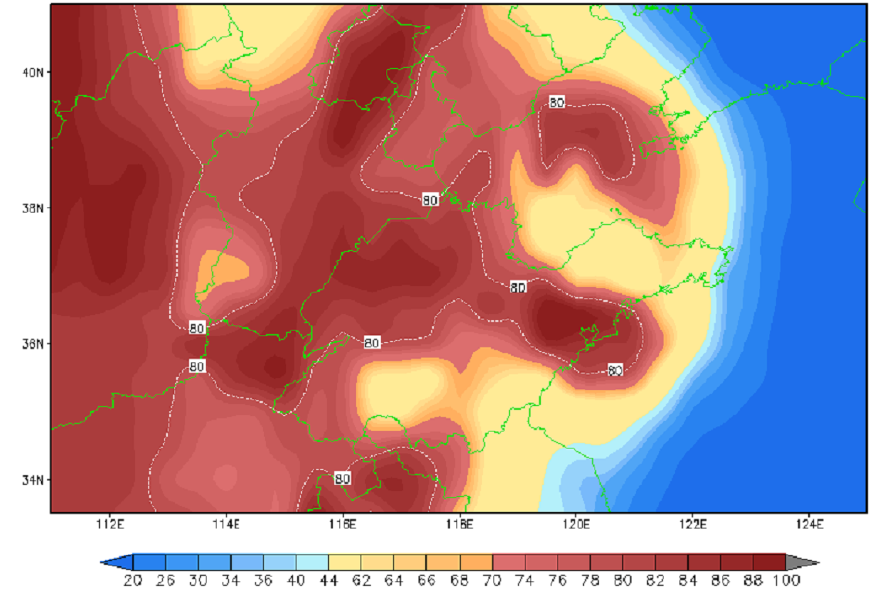
Figure 5. Regional correlation between PLAM/h index and visibility obtained from the 1006 groups of observation samples collected from January 2009 to December 2012. The regional distribution of the correlation with significance level exceeding 0.001 is